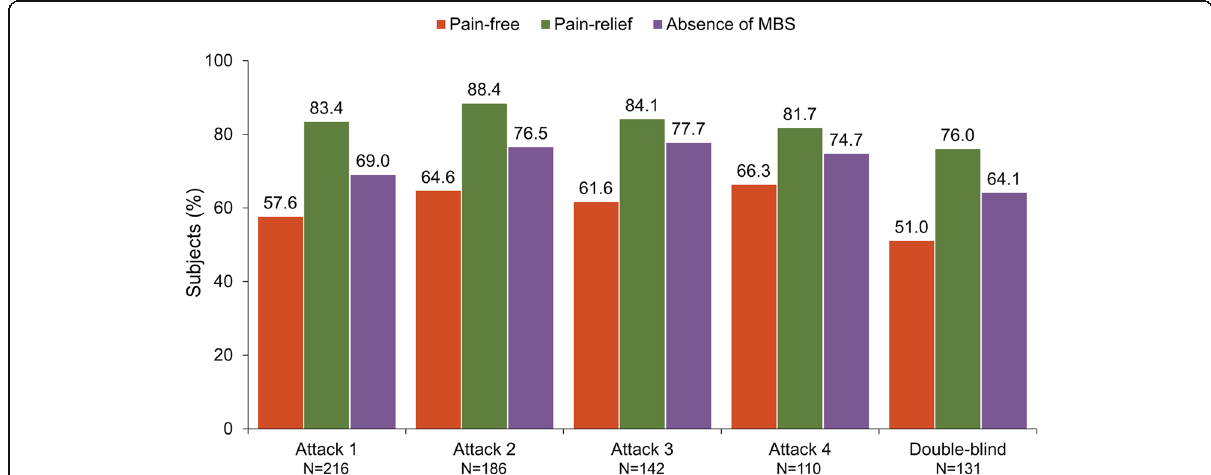
Fig. 2 Pain freedom, pain relief, and absence of the most bothersome symptom (MBS) at 2 h after treatment with DFN-11 in the open-label and double-blind study periods